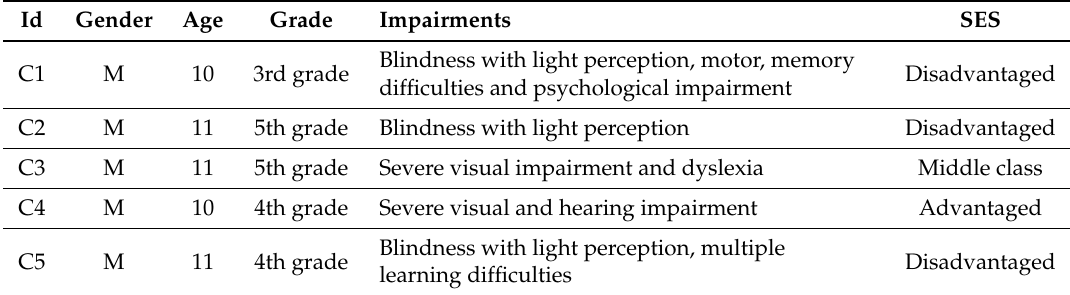
Table 1. Information about the children who participated in the design of the probe and the